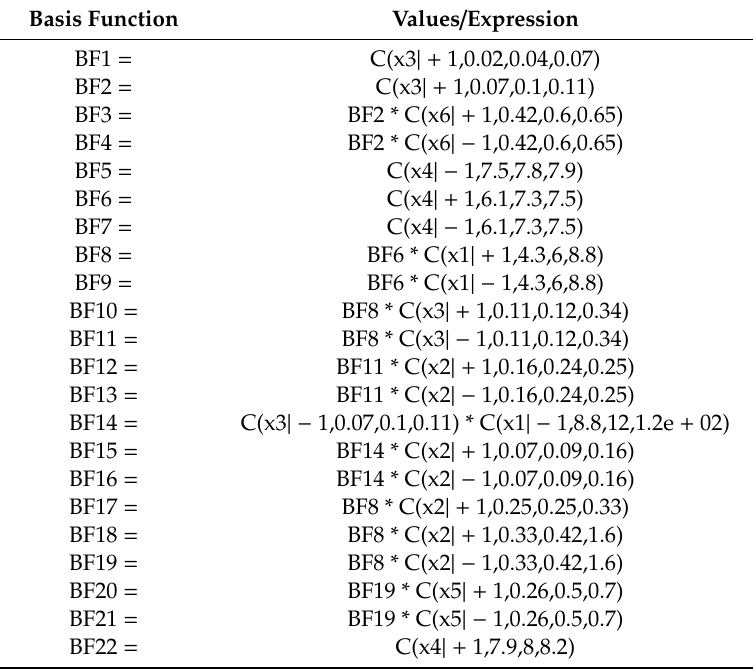
Table 6. Proposed MARS model based on the piecewise-cubic